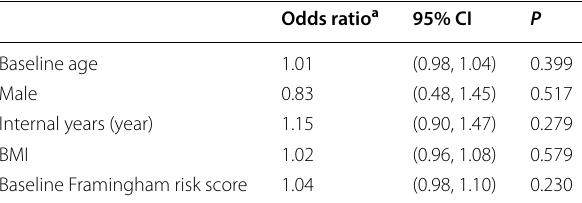
between factors